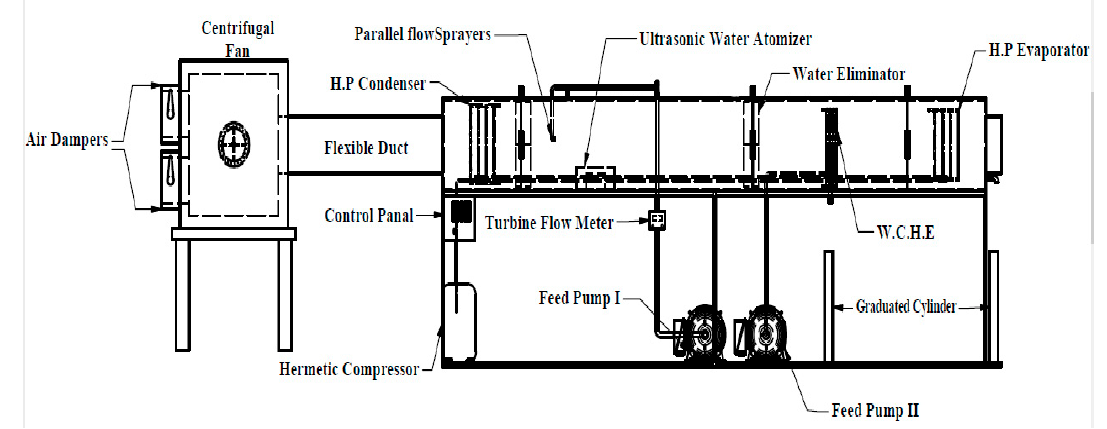
Figure 3. Schematic diagram of the components of the desalination system.